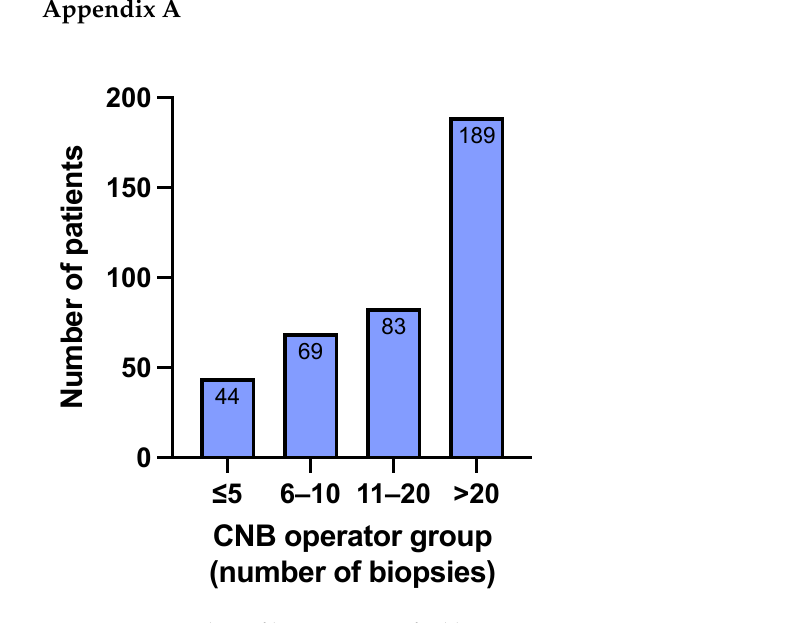
Figure A1. Number of biopsies stratified by CNB operator experience group. In n = 7 patients, the CNB operator was not known. CNB: core needle